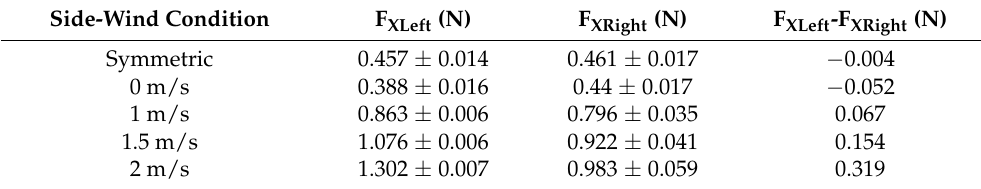
Table 3. F X on the left and right sides with different side-wind boundary conditions.